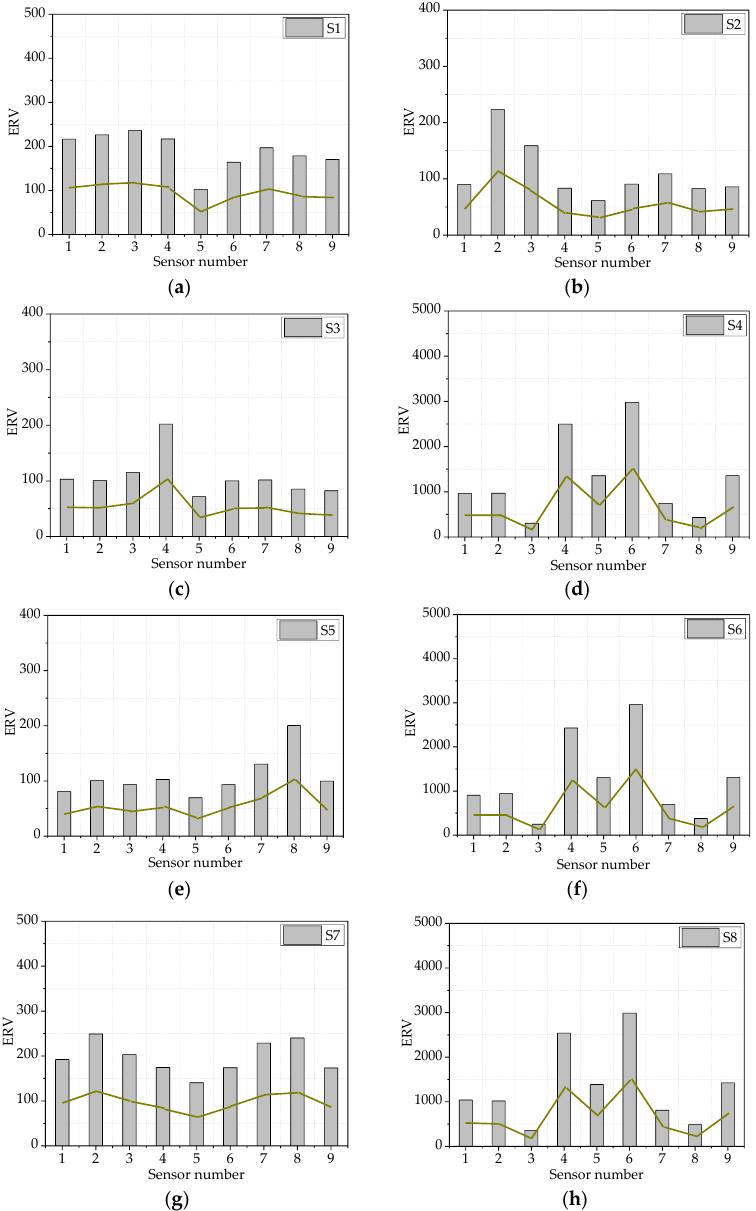
Figure 7. Two-dimensional ERV diagrams of different working scenarios. ( a ) ERV value of working scenario S1. ( b ) ERV value of working scenario S2. ( c ) ERV value of working scenario S3. ( d ) ERV value of working scenario S4. ( e ) ERV value of working scenario S5. ( f ) ERV value of working scenario S6. ( g ) ERV value of working scenario S7. ( h ) ERV value of working scenario S8.